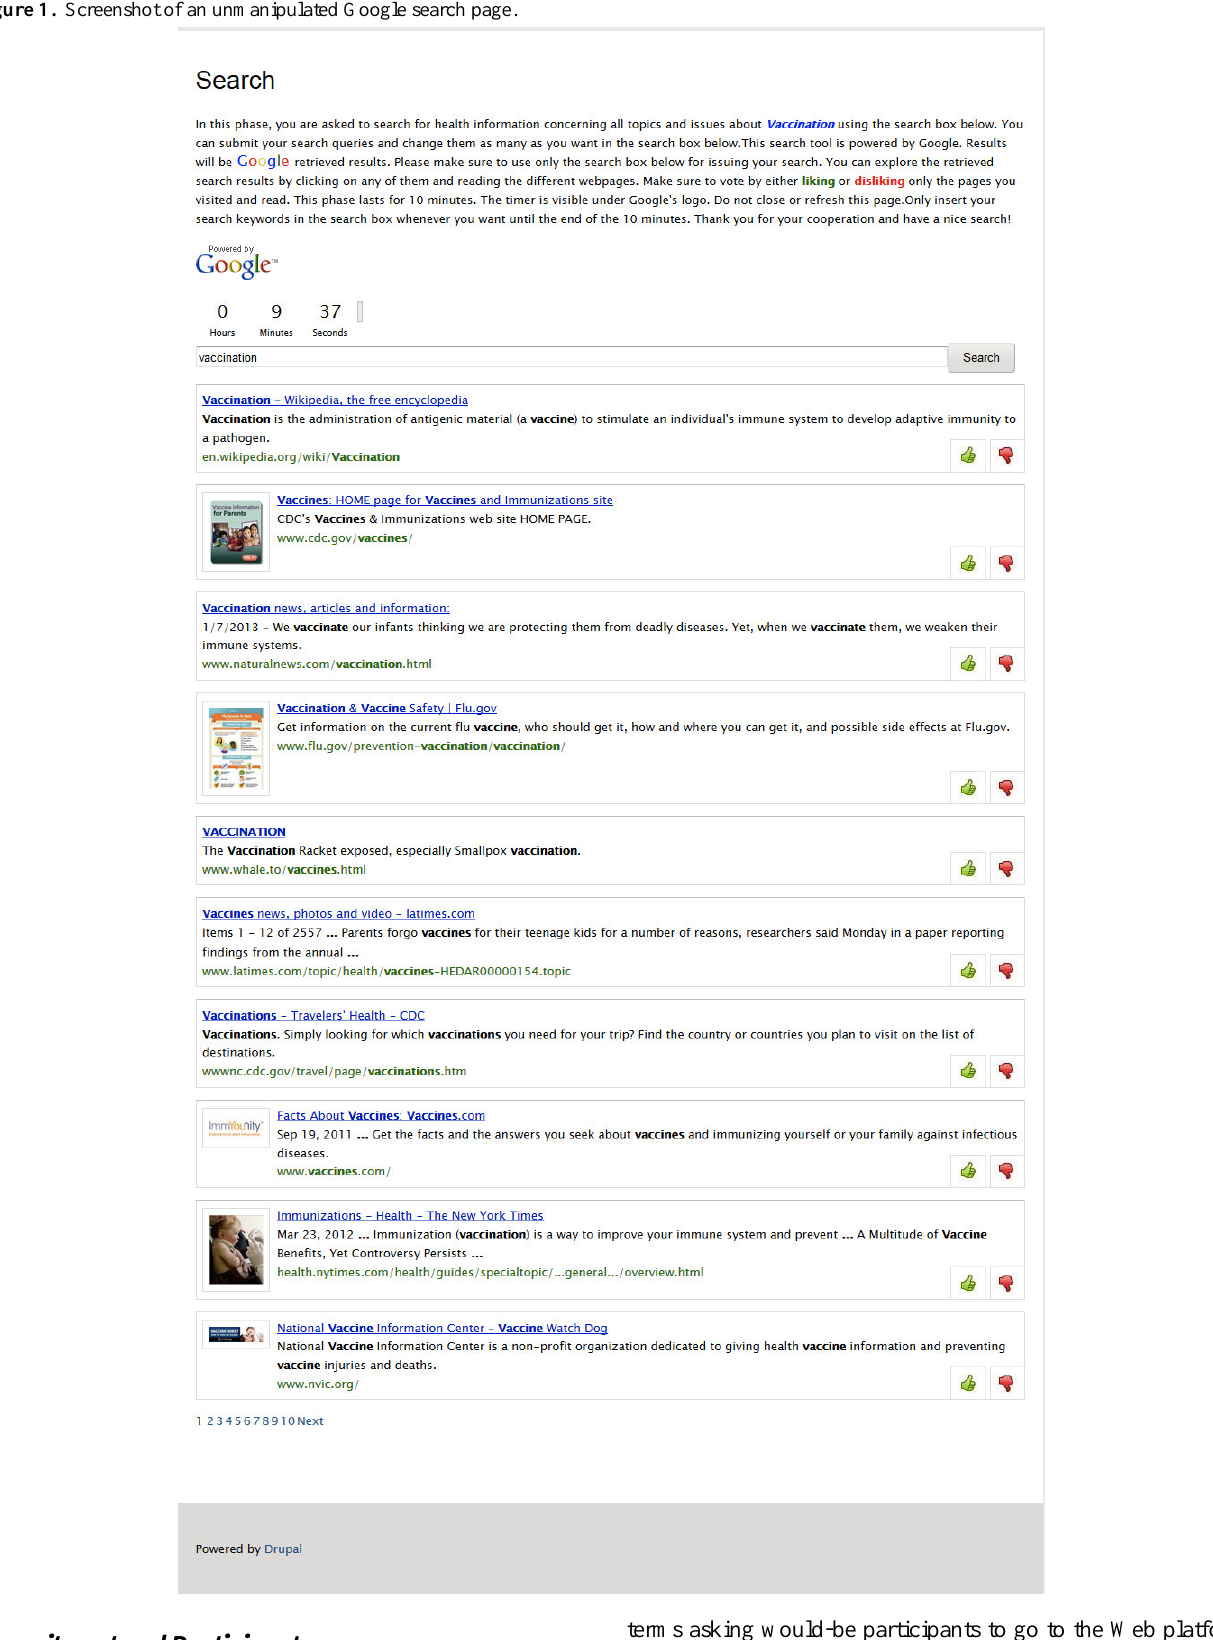
Figure 1. Screenshot of an unmanipulated Google search